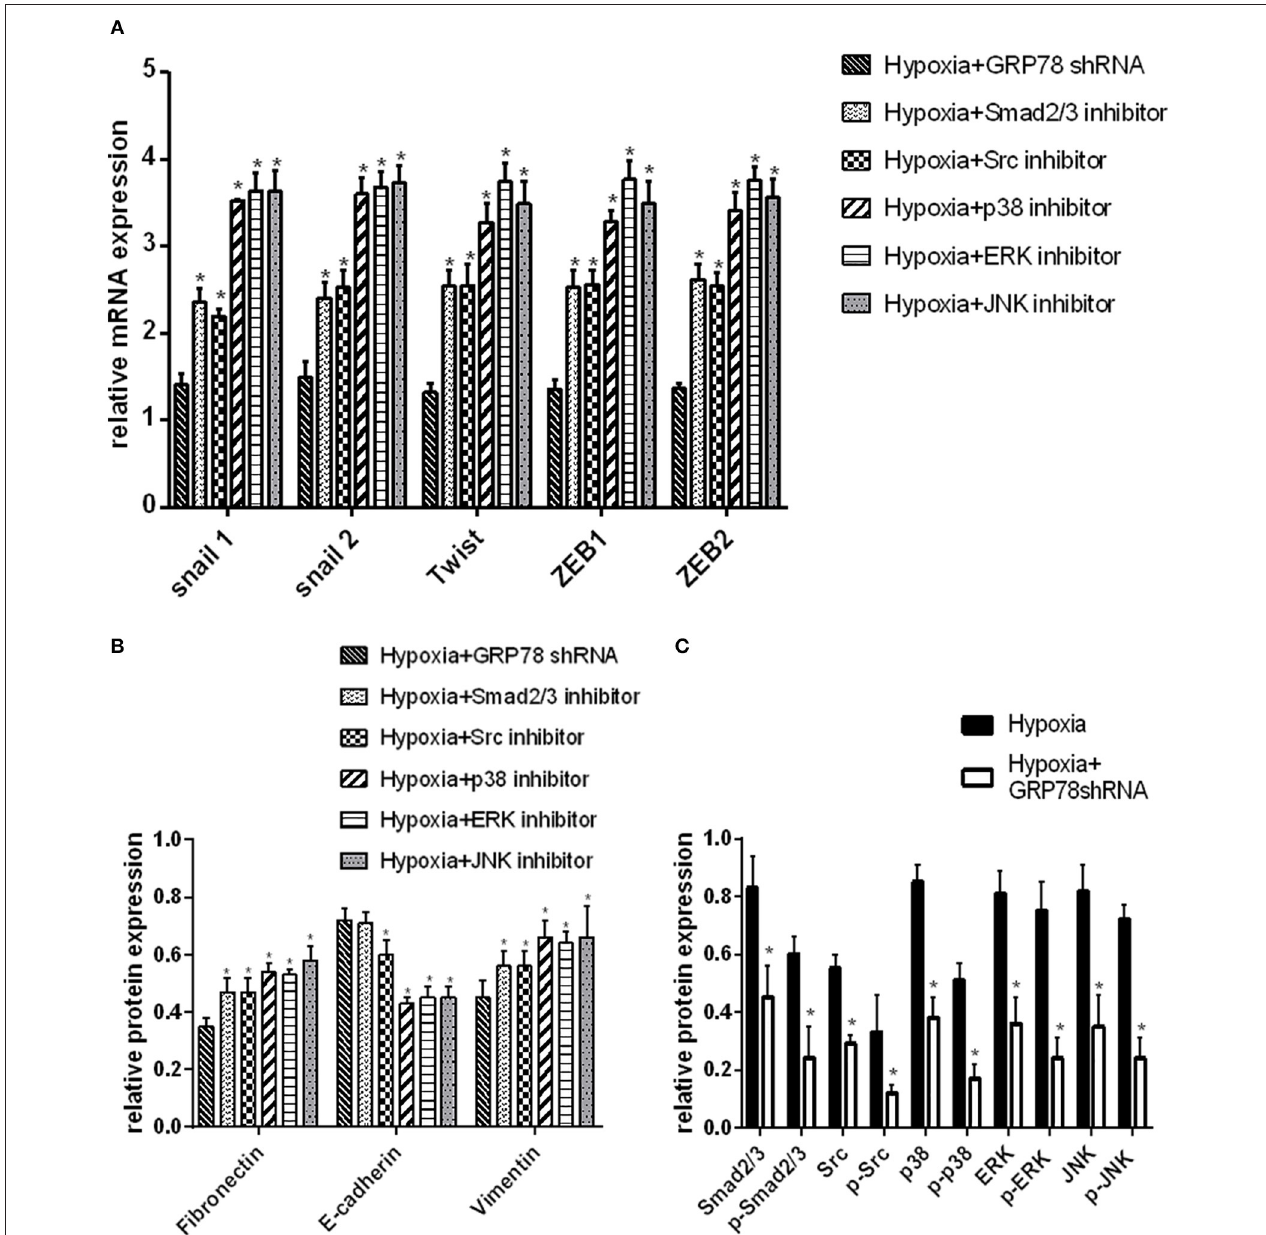
FIGURE 3 | GRP78 is the upper reaches of the Smad2/3, Src and MAPK pathways in hypoxia-induced EMT in A549 cells. (A) The mRNA relative value (control group) of EMT transcription factors is plotted (mean ± SD in three separate experiments). * P < 0.05, compared with EMT transcription factors in A549 cells under hypoxia condition separately inhibited by Smad2/3, Src, p38, ERK, and JNK inhibitors, the expression is higher than that in GRP78 knockdown A549 cells under hypoxia. (B) The protein relative value (GAPDH) of EMT markers was examined by Western blot analysis and plotted (mean ± SD in three separate experiments). * P < 0.05, compared with EMT markers of A549 cells under hypoxia condition separately inhibited by Smad2/3, Src, p38, ERK, and JNK inhibitors, the expression is higher than that in GRP78 knockdown A549 cells in the hypoxia. (A,B) indicate that the inhibition effect of GRP78 silencing is more powerful than those of the five other inhibitors. (C) The protein relative values (GAPDH) of Smad2/3, Src, p38, ERK, JNK, and their phosphorylated forms were examined by Western blot analysis and plotted (mean ± SD in three separate experiments). * P < 0.05, compared with A549 cells under hypoxia, the expression levels of Smad2/3, Src, p38, ERK, JNK, and their activation forms decrease compared with those in GRP78 knockdown A549 cells under hypoxia. After GRP78 silencing, the expression and activation of these proteins are inhibited significantly.